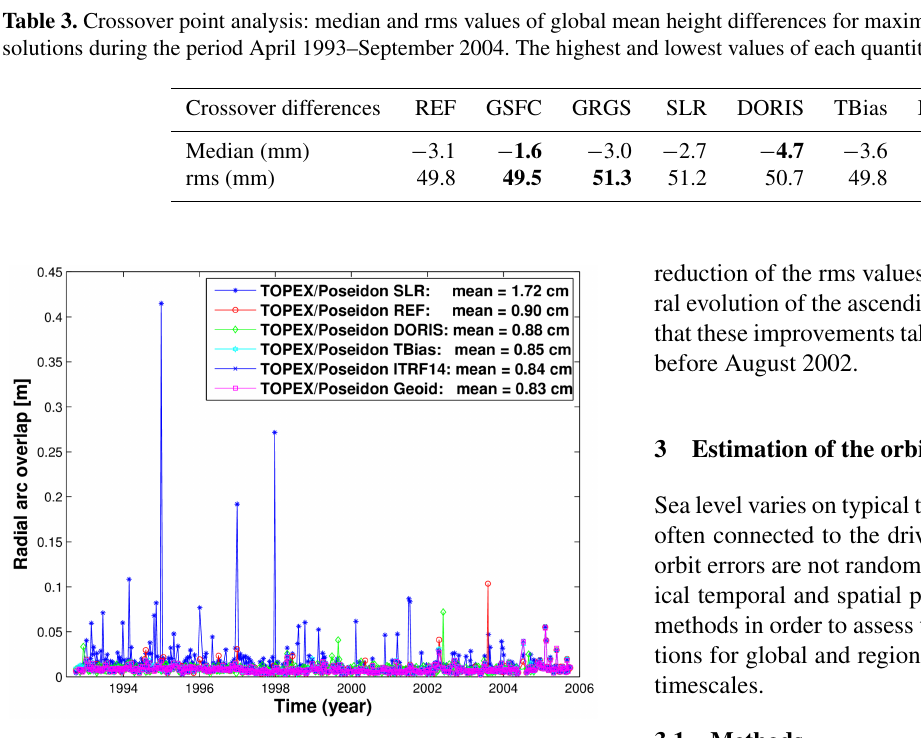
Figure 2. Radial arc overlaps of TOPEX/Poseidon REF, SLR, DORIS, TBias, ITRF14, and Geoid